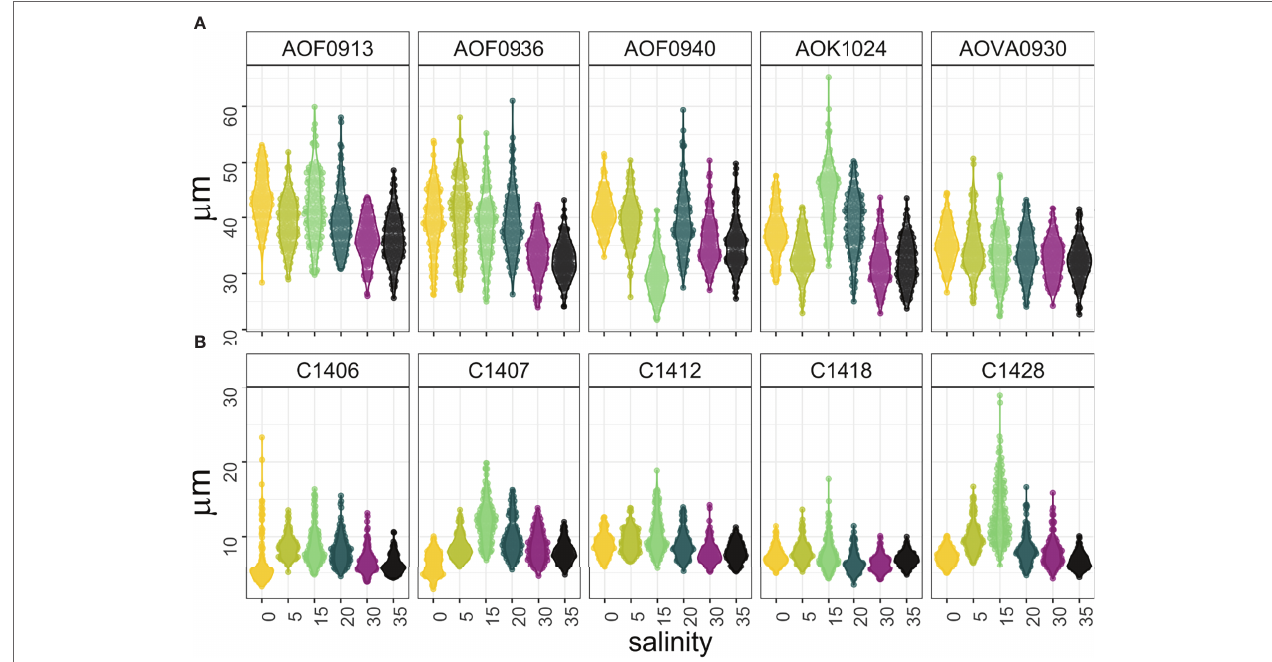
FIGURE 5 | Cell length of (A) A. ostenfeldii and (B) S. marinoi strains along a salinity gradient (n =